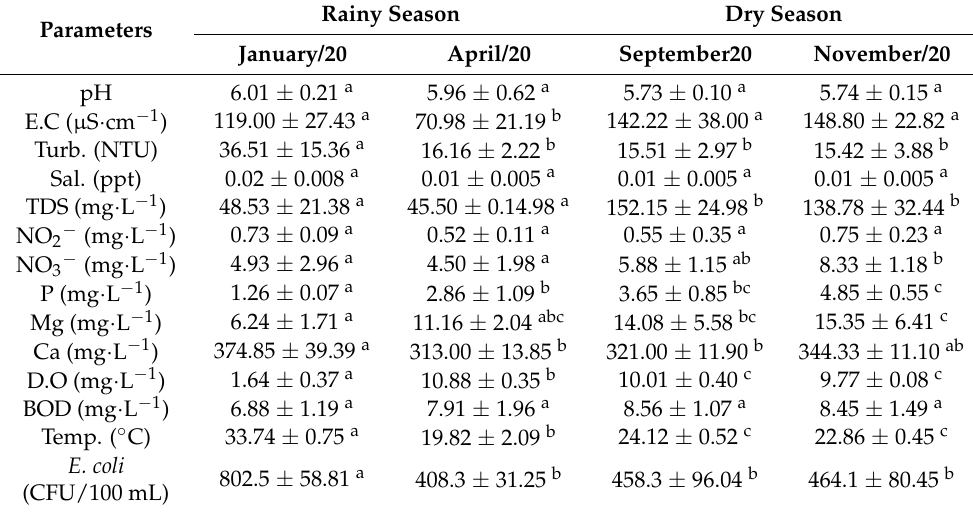
Table 3. Physicochemical analysis at the six sampling